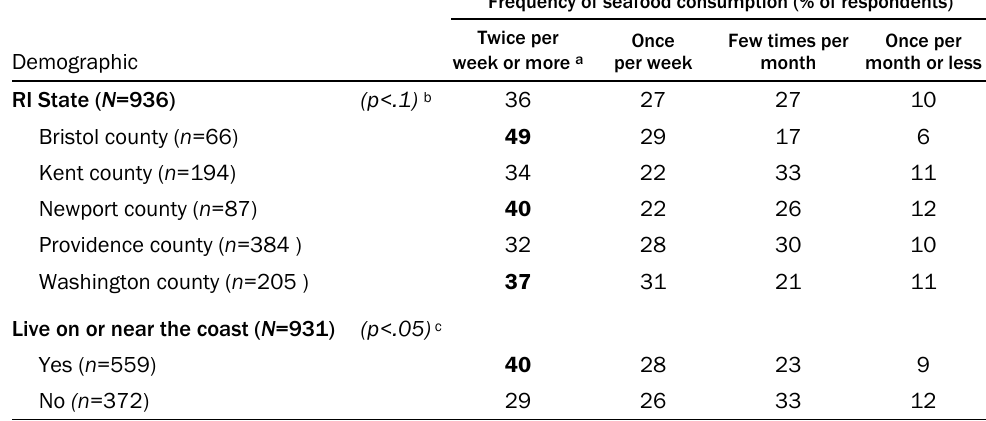
Table 2. Frequency of Seafood Consumption among Survey Respondents, Separated by the County of Primary Residence and Self-selection if Residence is on or near the Rhode Island